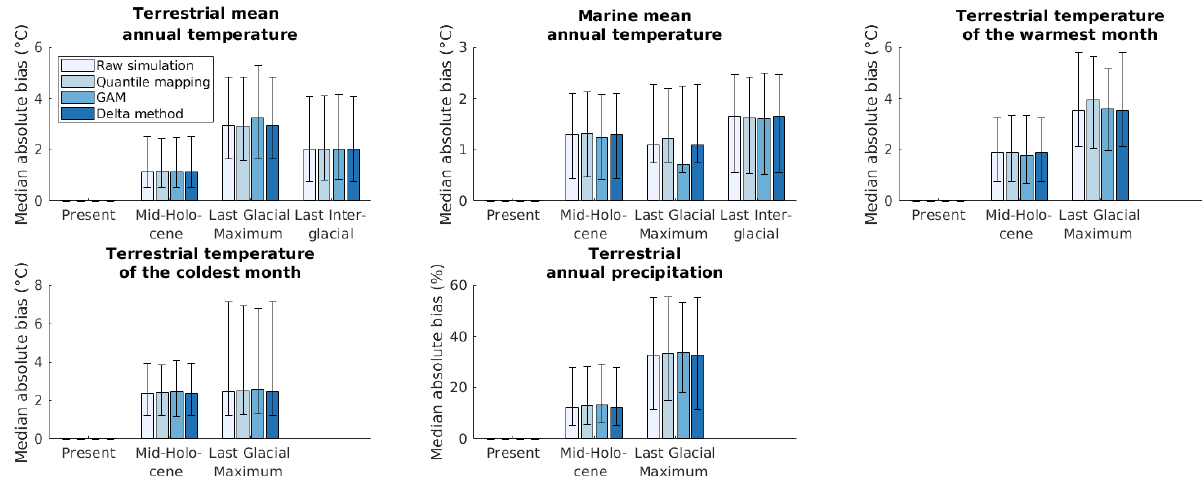
Figure A3. Median absolute biases of the climate change signal (CCMAB in Eq. 10). Error bars represent 25% and 75% weighted quantiles of the local absolute climate change biases available for the given climate variable and point in